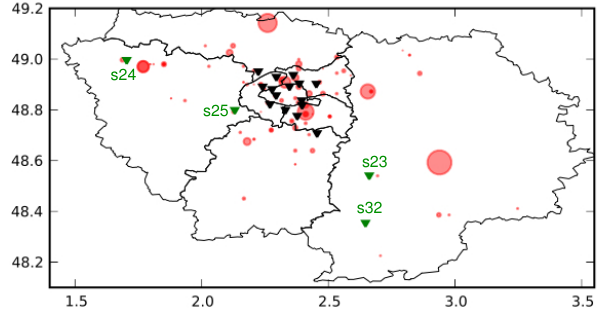
Fig. 3. Measurement stations (triangles), and main point sources, for SO 2 . The circles areas are proportional to the sources emis- sion rate. The black triangles are urban stations, green triangles are periurban and rural stations (the names of these stations also are